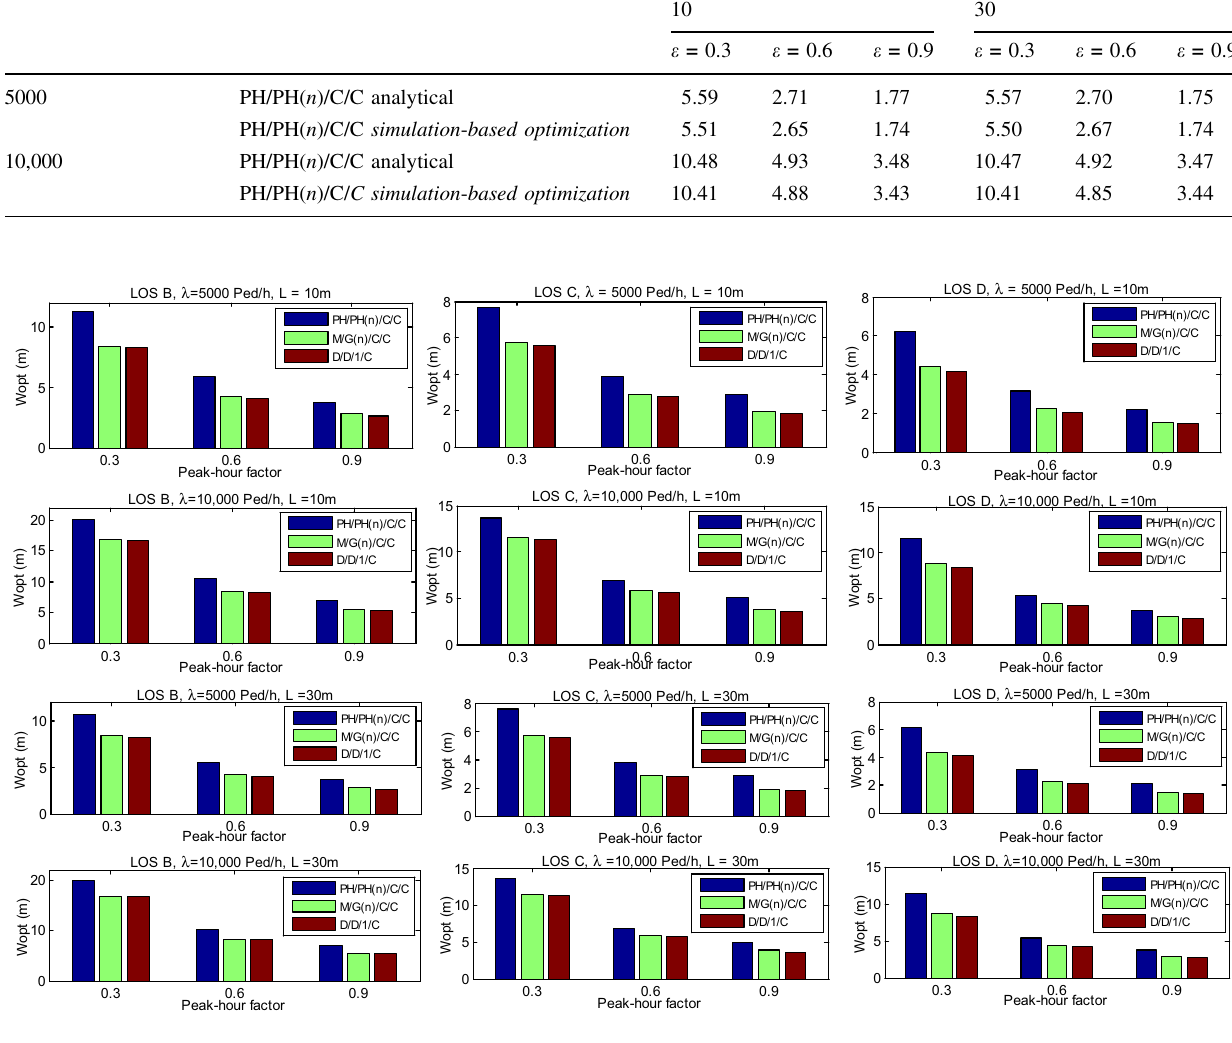
Fig. 6 Comparitive analysis of different design